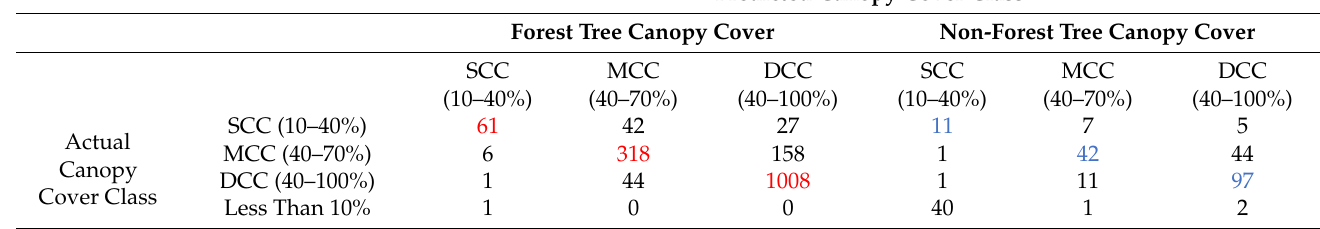
Table 4. Visual accuracy assessment result of CCEM-derived canopy cover map (predicted canopy cover map). The red font in the results indicates the number of interpretation grids that correctly estimated canopy cover class in CCEM derived canopy cover map. The blue font in the results indicates the number of grids that correctly estimated canopy cover class in CCEM derived canopy cover map, but failed in land